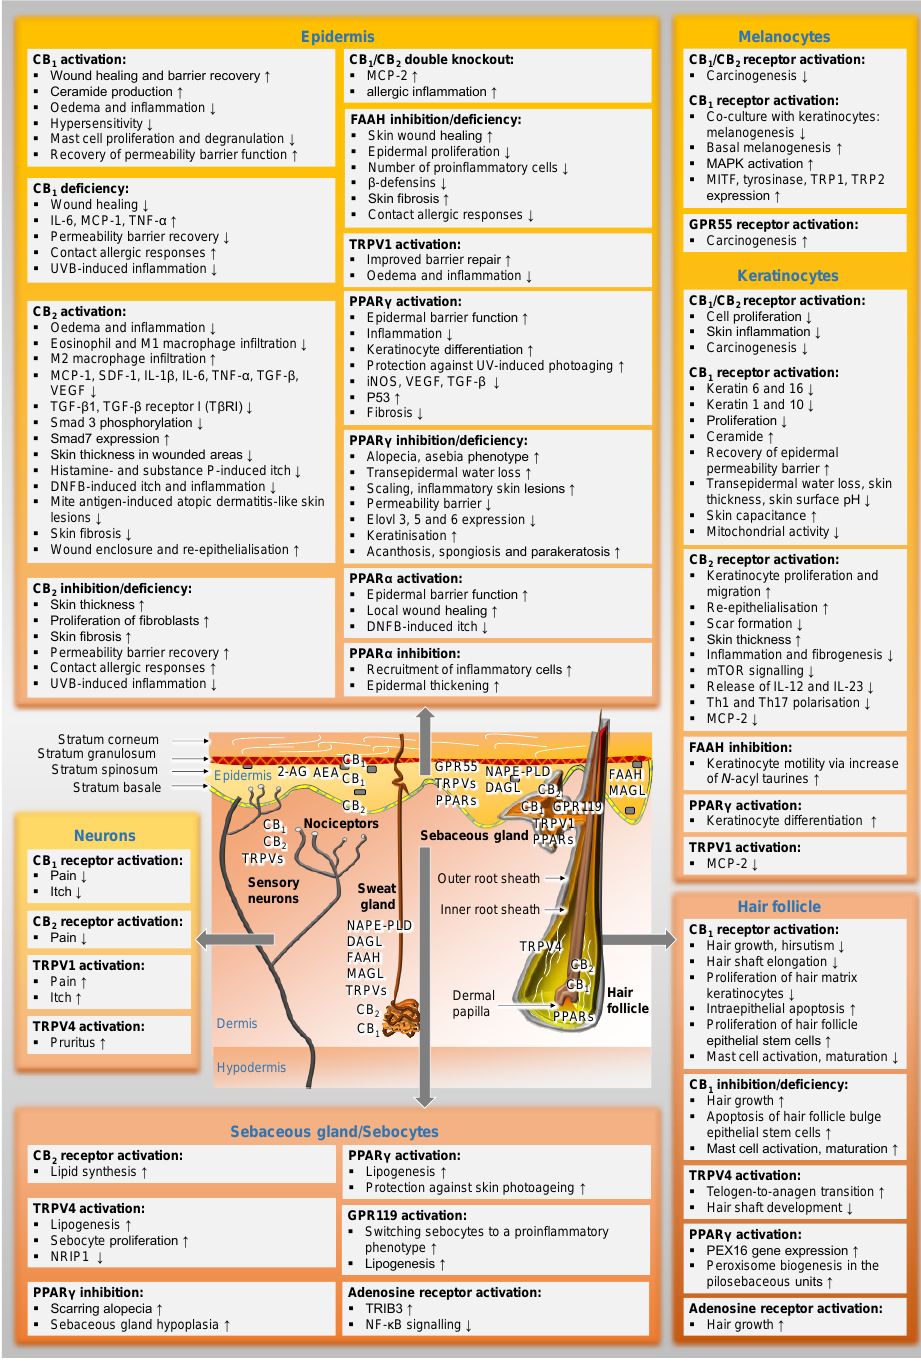
Figure 2. Distribution of the elements of the endocannabinoid system in the skin and their functional effects. In the text boxes, the regulations proven in the literature have been indicated. The term deficiency always refers to the fact that results from experiments with knockout animals are included here. ↑ , upregulated; ↓ , downregulated; AEA, N -arachidonoyl ethanolamine (anandamide); 2-AG, 2-arachidonoyl glycerol; CB 1 , cannabinoid receptor 1; CB 2 , cannabinoid receptor 2; DAGL, diacyl- glycerol lipase; DNFB, 1-fluoro-2,4-dinitrobenzene; Elovl 3, 5 and 6, elongation of very-long-chain fatty acids-like group of enzymes; GPR, G protein-coupled receptor; FAAH, fatty acid amide hy- drolase; IL, interleukin; iNOS, inducible nitric oxide synthase; MAGL, monoacylglycerol lipase; MAPK, mitogen-activated protein kinases; MCP, monocyte chemoattractant protein; MITF, mi- crophthalmus-associated transcription factor; mTOR, mammalian target of rapamycin; NAPE-PLD,